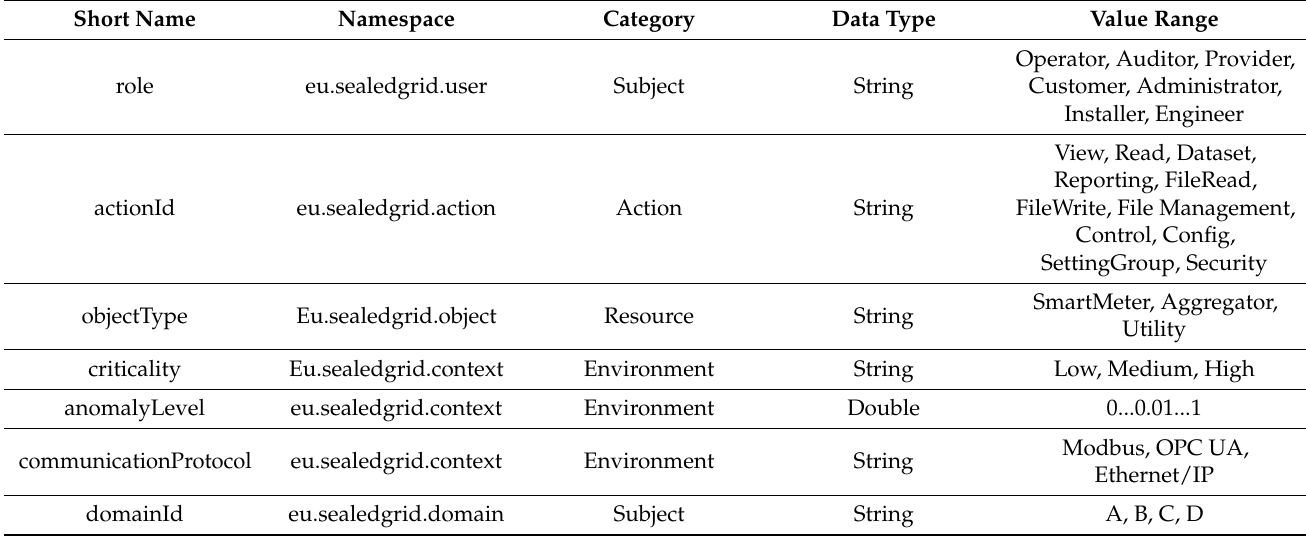
Table 1. Defined